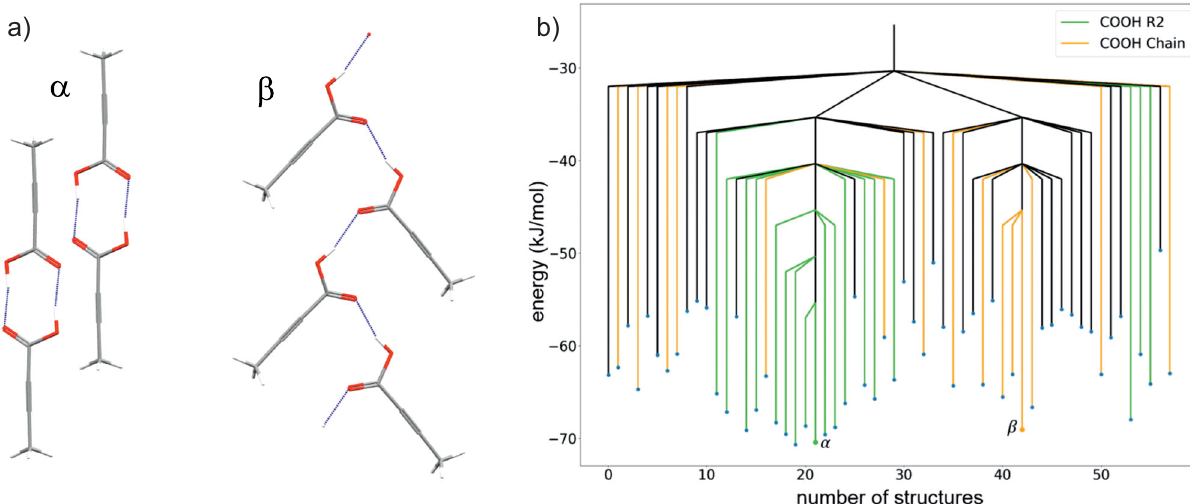
Fig. 5 Hydrogen bonding and disconnectivity graph for tetrolic acid. a Hydrogen bonding in the two known polymorphs of tetrolic acid. Carbon atoms are grey, oxygen red and hydrogen white. Hydrogen bonds are shown as dashed blue lines. b Disconnectivity graph from threshold simulations for tetrolic acid with two molecules in a P 1 unit cell. The horizontal axis labels the number of structures located during the threshold simulation. The order of structures is chosen to group together structures separated by low energy barriers. A disconnectivity graph showing the entire sampled energy range is shown in Supplementary Fig. 5. Colours of edges represent the hydrogen bond motif of connected minimized structures where black edges are structures identi fi ed as having neither of the motifs. Hydrogen bond motifs were identi fi ed with Mercury 59 , identifying hydrogen bonds as H...O contacts with a separation less than the sum of van der Waals radii + 0.1 Å and an O – H...O angle >125 ∘ .